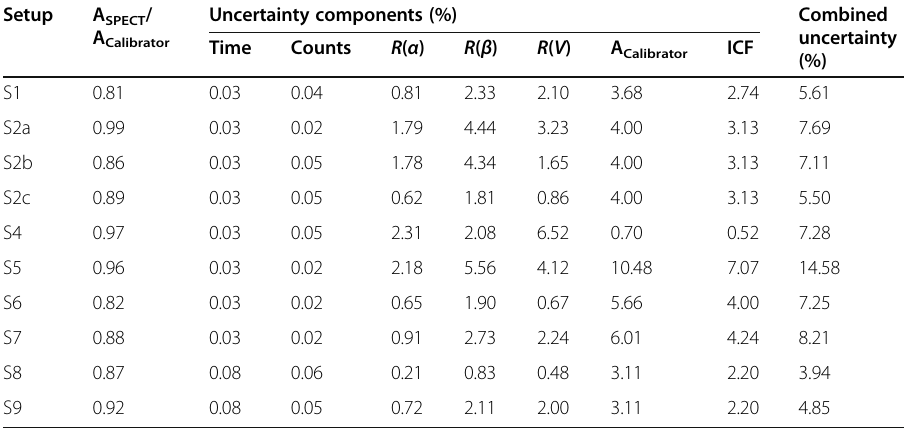
Table 7 Uncertainty budget for kidney activity ratios (A SPECT : SPECT-based activity, A Calibrator : radionuclide calibrator-based activity, R( α ) / R( β ) / R(V): uncertainty components introduced by the recovery originating from α , β and V, respectively)